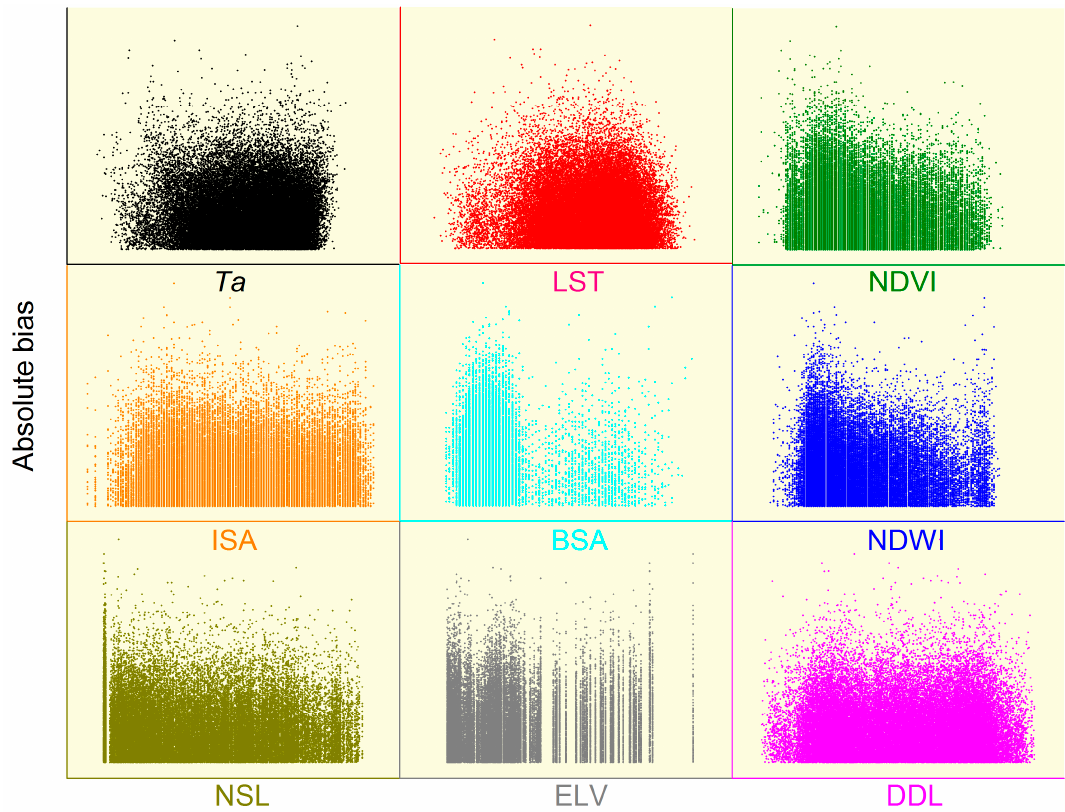
Figure 9. Scatter plots between the absolute bias and the nine variables (i.e., Ta , LST, NDVI, ISA, BSA, NDWI, NSL, ELV, and DDL).